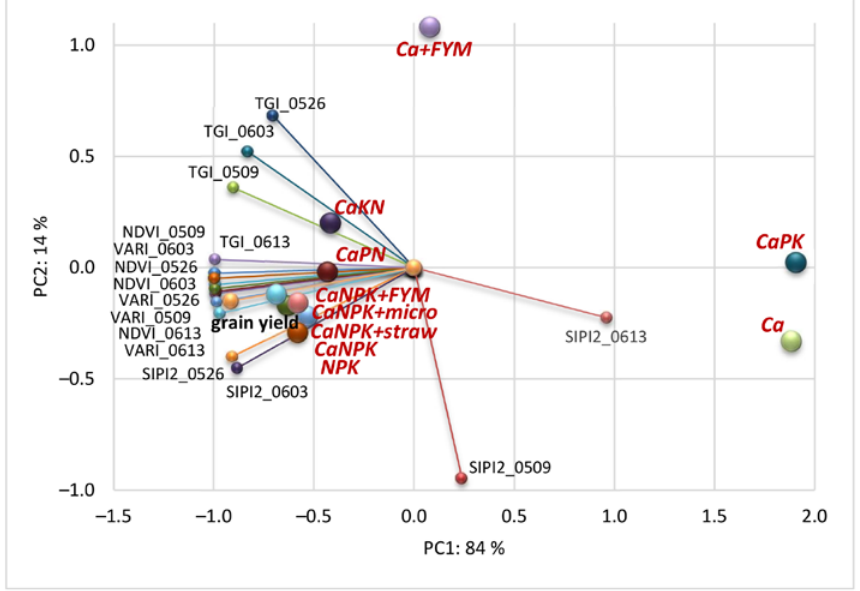
Figure 4. The results of PCA presenting multivariate differences between treatments and